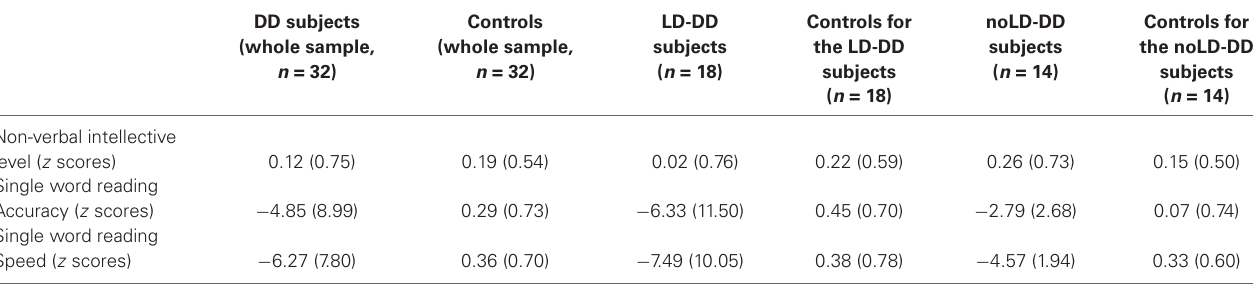
Table 1 | Means and SDs (in brackets) of the whole DD sample, of the sub-groups of DD participants with (LD) and without (noLD) a history of language delay and the respective control groups on non-verbal intellective level and single word reading measures